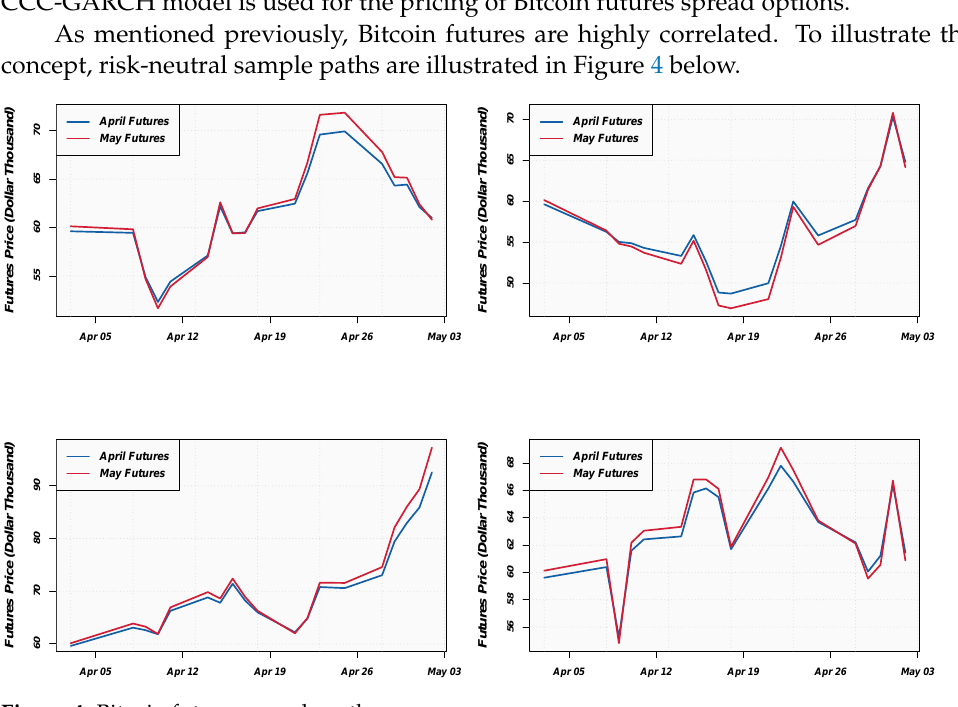
Figure 4. Bitcoin futures sample